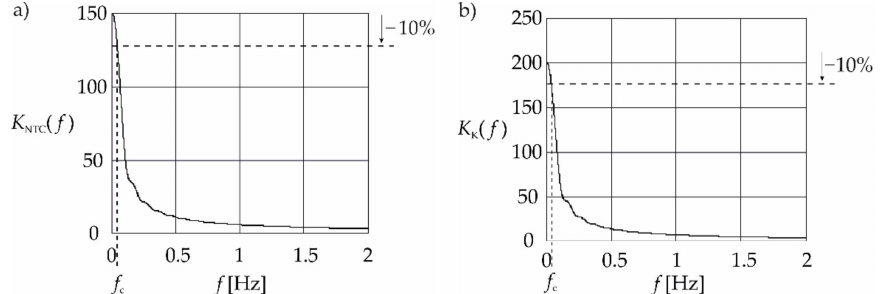
Figure 6. Results of the transformation of the impulse responses of both sensors according to Equation (26): negative temperature coefficient [NTC] sensor ( a ); K-type thermocouple sensor ( b